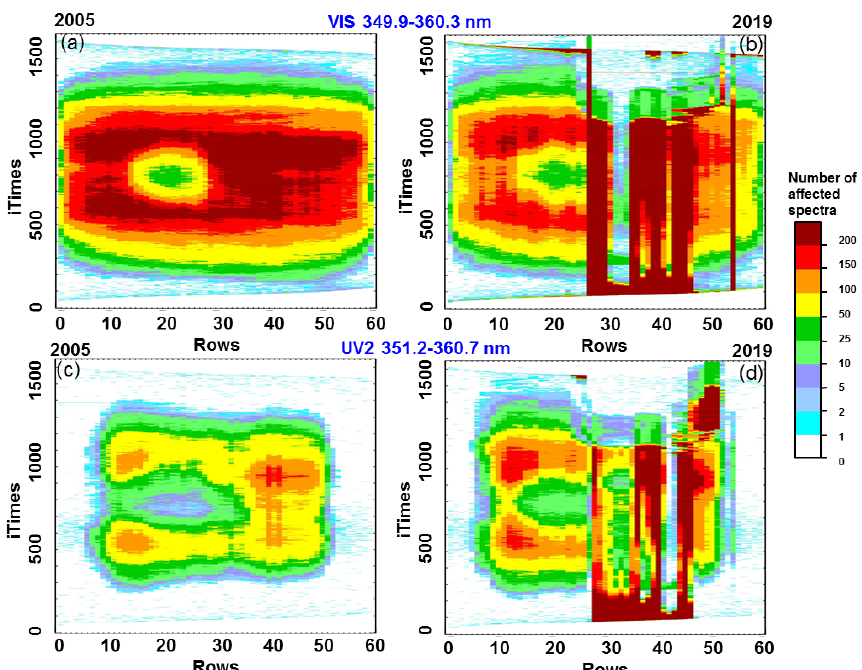
Figure 11. Distribution of the number of affected spectra (DI > 0.01) for March 2005 (a, c) and 2019 (b, d) for vis of 349.9–360.3nm (a, b) and UV2 of 351.2–360.7nm (c, d) . The row anomaly is responsible for the stripes of high values shown in